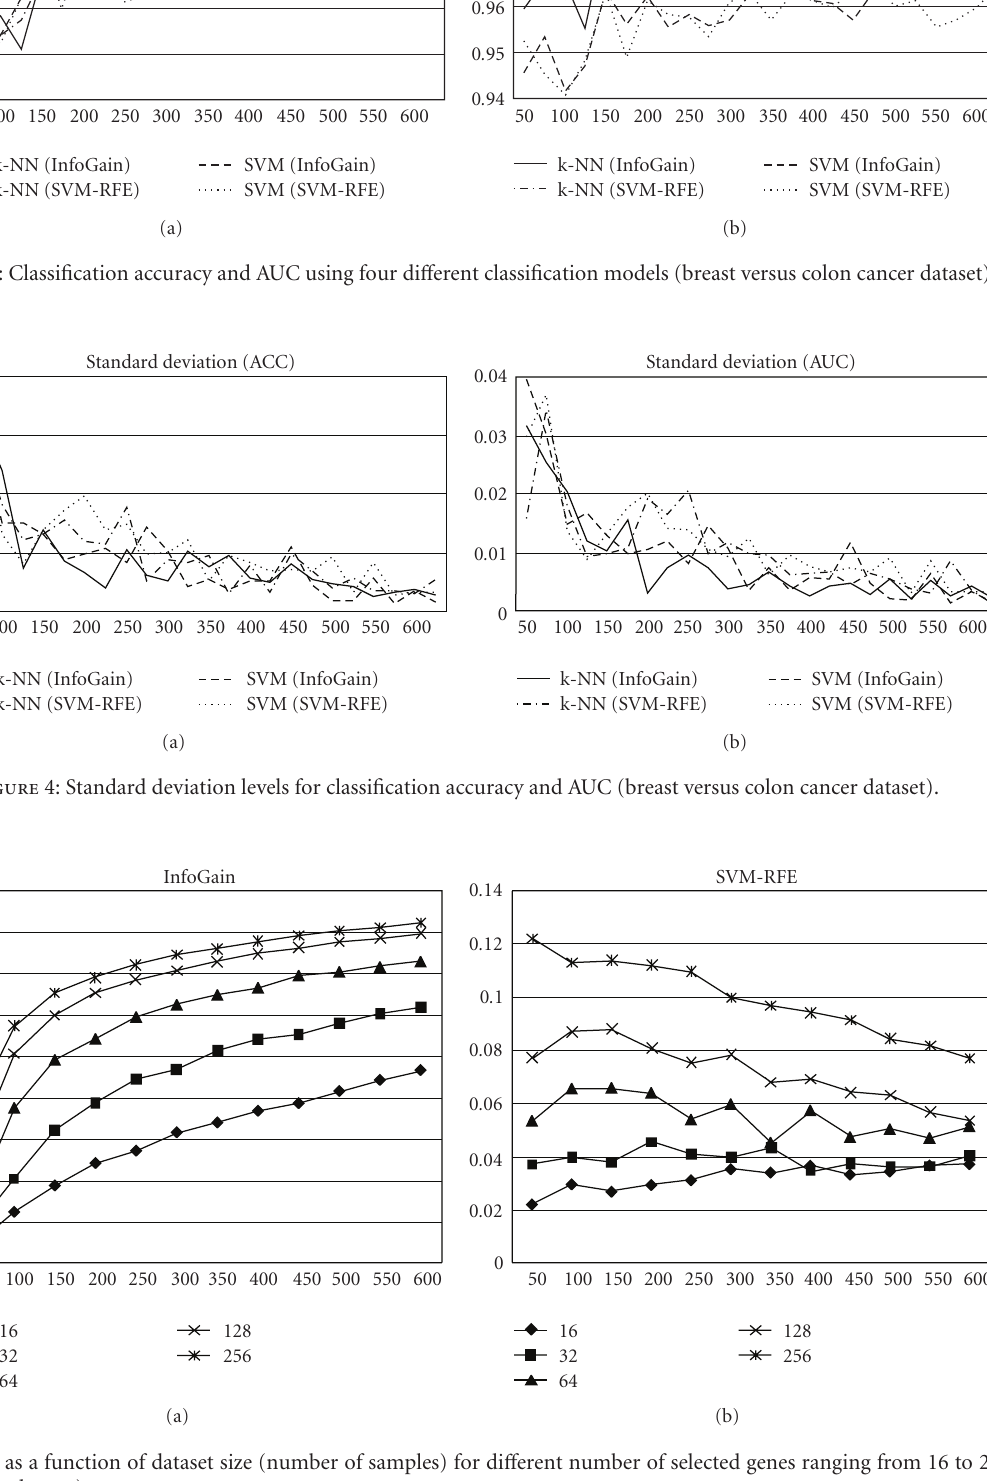
Figure 5: Overlap as a function of dataset size (number of samples) for di ff erent number of selected genes ranging from 16 to 256 (breast versus colon cancer